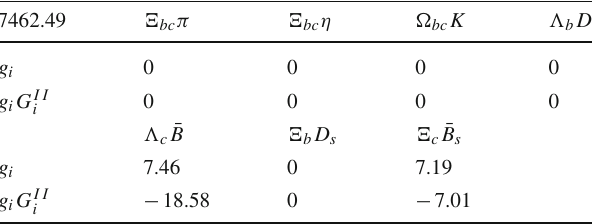
Table 14 Coupling constants to various channels and g i G II with q